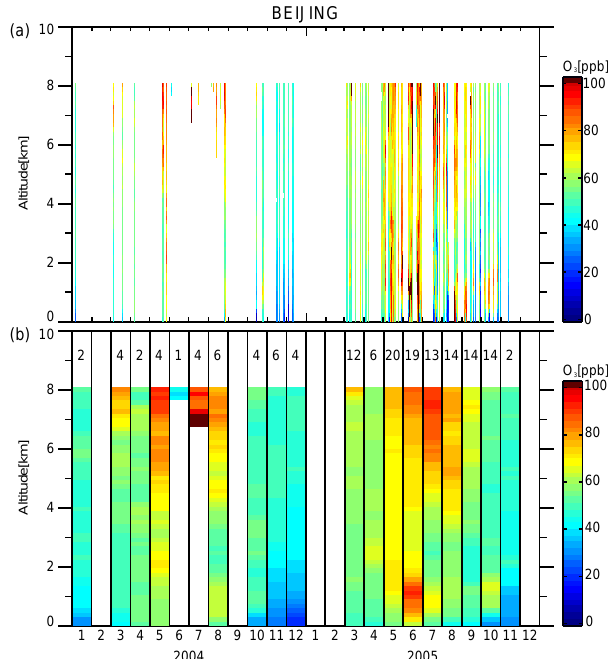
Figure 1. (a) Time–altitude cross section of daily mean ozone mix- ing ratios observed by MOZAIC over Beijing in 2004 and 2005. Two measurements were conducted on most days. Daily values are the average of the two data sets obtained on the same day. (b) Same as (a) but for monthly mean ozone mixing ratios. The number of data used in the analysis for each month are